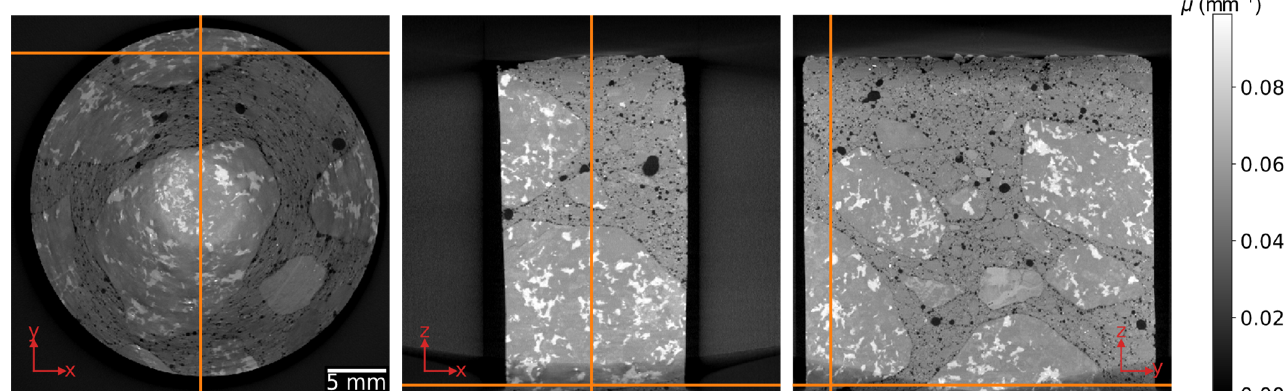
Figure 1. Orthogonal slices through the volume of a concrete rod as reconstructed by Feldkamp, Davis and Kress (FDK). The orange lines indicate the relative position of the cross sections.